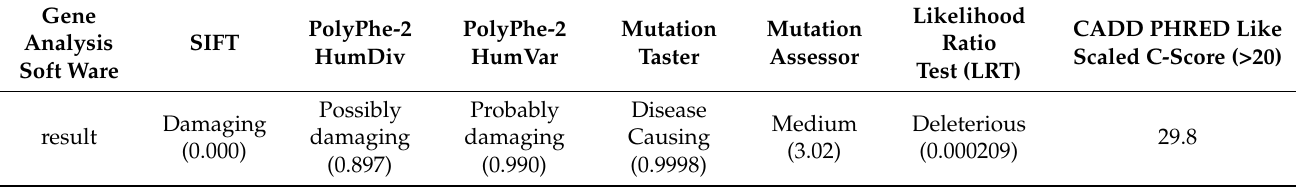
Figure 2. Surgical findings. ( a ) Multiple hepatic cysts occupy the upper abdominal cavity. Extra- hepatic cysts compress the stomach (yellow arrowheads). ( b ) Intracystic bleeding scars are present. Intraoperative cytological analysis of the cyst content was negative for malignancy (red arrows). ( c ) Abdominal cavity after cystectomy and hepatectomy. Table 1. Summary of in-silico